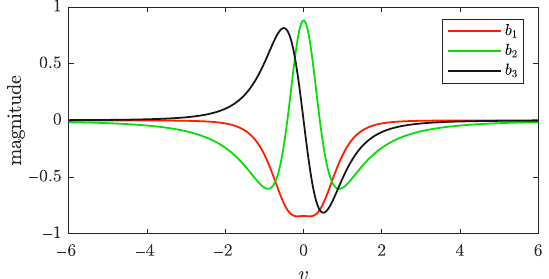
Figure 2. The b 1 ( v ) , b 2 ( v ) , and b 3 ( v )